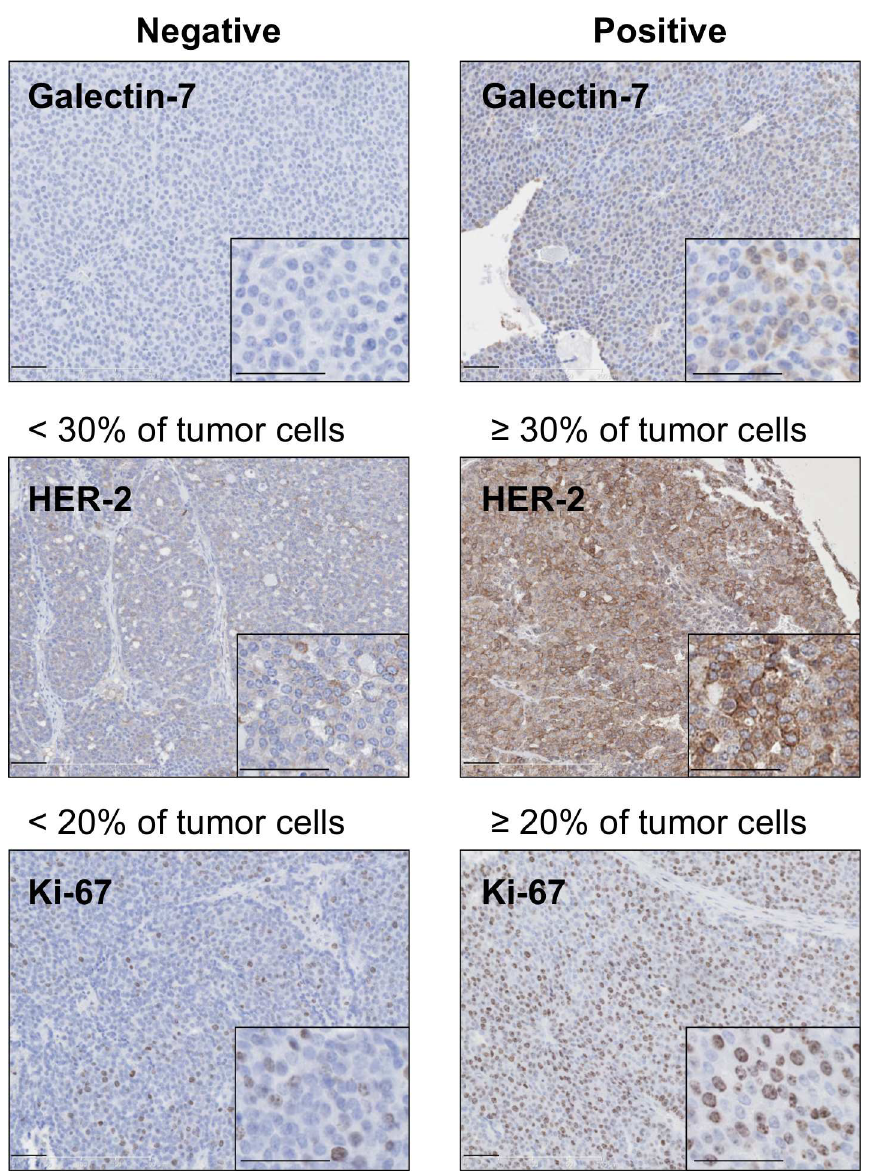
Fig 3. Immunohistological analysis of mammarytumour markersin presenceor absence of gal-7. Immunohistochemicalstainingshowingmembrane-boundHER-2-positive cells and nuclear Ki67 expression in mammary tumors that were negative ( left panels )or positive ( right panels ).Scale bars, 50 μ m and 25 μ m (insets).